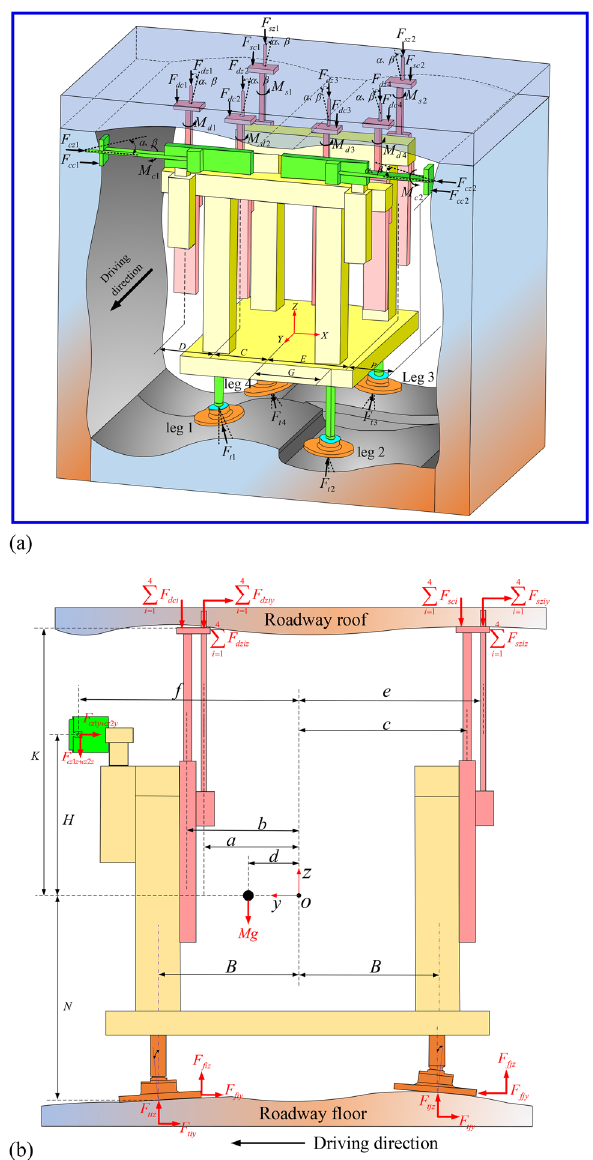
Figure 2. Mechanical model of anchorage group under overall uneven working condition of roadway floor: ( a ) axonometric drawing of anchorage system; ( b ) side view of anchorage